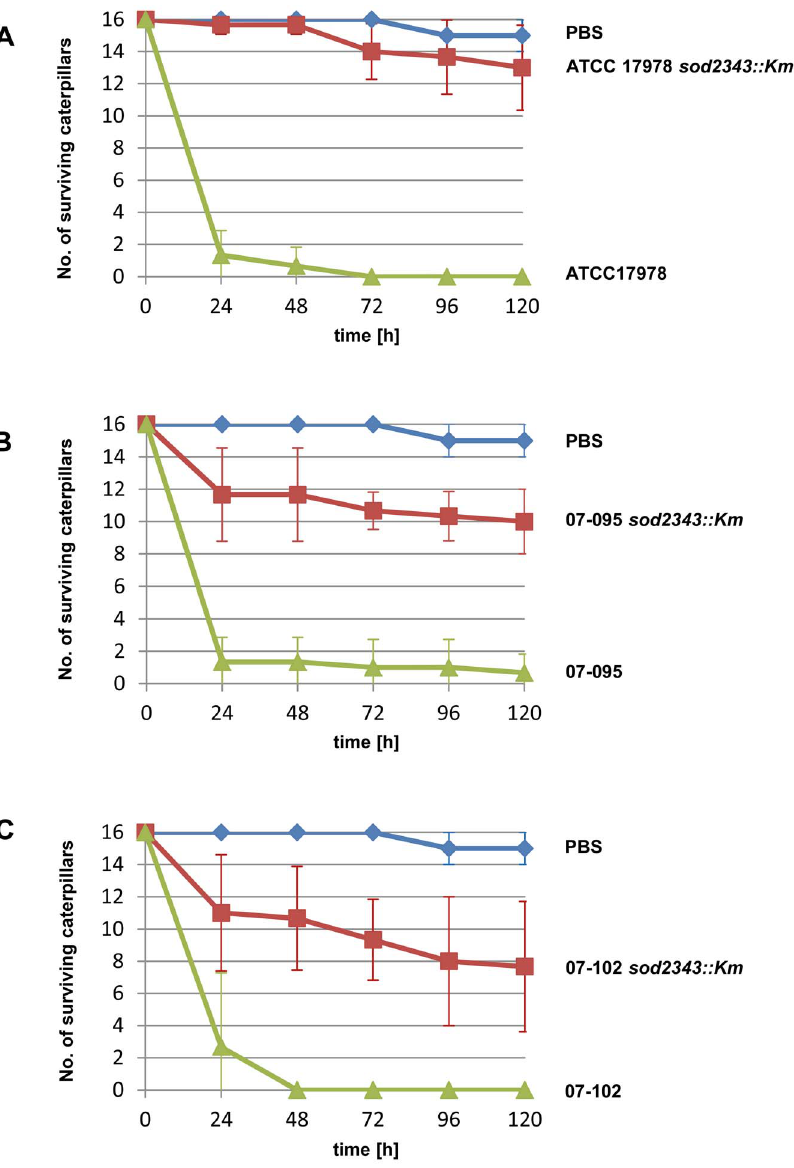
Figure. 5. A.baumanniisod2343 mutants are attenuated in the Galleriamellonella infection model. (A) Survival of Galleria caterpillars injected with 3 6 10 5 CFU of ATCC 17978 sod2343::Km (red), ATCC 17978 (green) and PBS (blue). (B) Infection with 1.5 6 10 6 CFU of 07–095 and its sod2343::Km derivative. (C) Infection with 3 6 10 5 CFU of 07–102 and its sod2343::Km mutant. Results represent means and standard deviations of at least three independent experiments of 16 larvae per